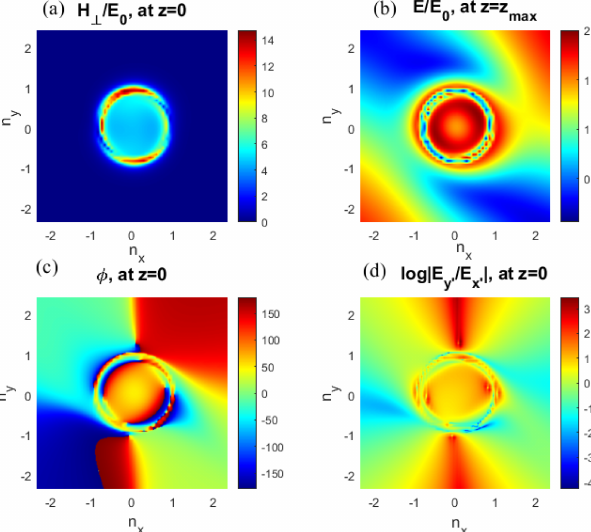
Figure 1. Nighttime ionosphere model: (a) the electron plasma den- sity and (b) the collision frequency between electron and neutral particles (solid line) and collision frequency between ion and neu- tral particles (dashed line).